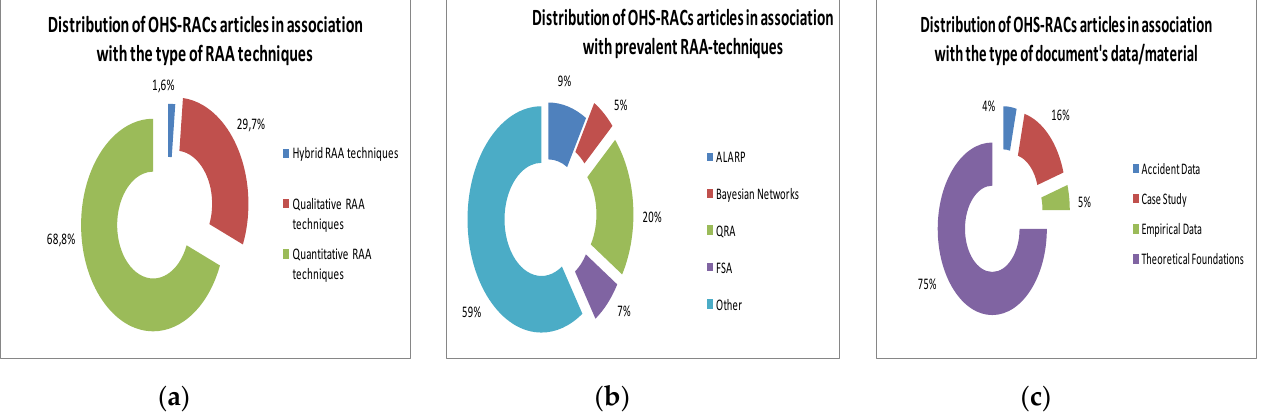
Figure 13. Theringcharts illustrate the distribution of OHSRAC articles published during the period of 2000 – 2019 in association with the ( a ) type of RAA techniques, ( b ) specific prevalent RAA techniques, and ( c ) type of document data or material.